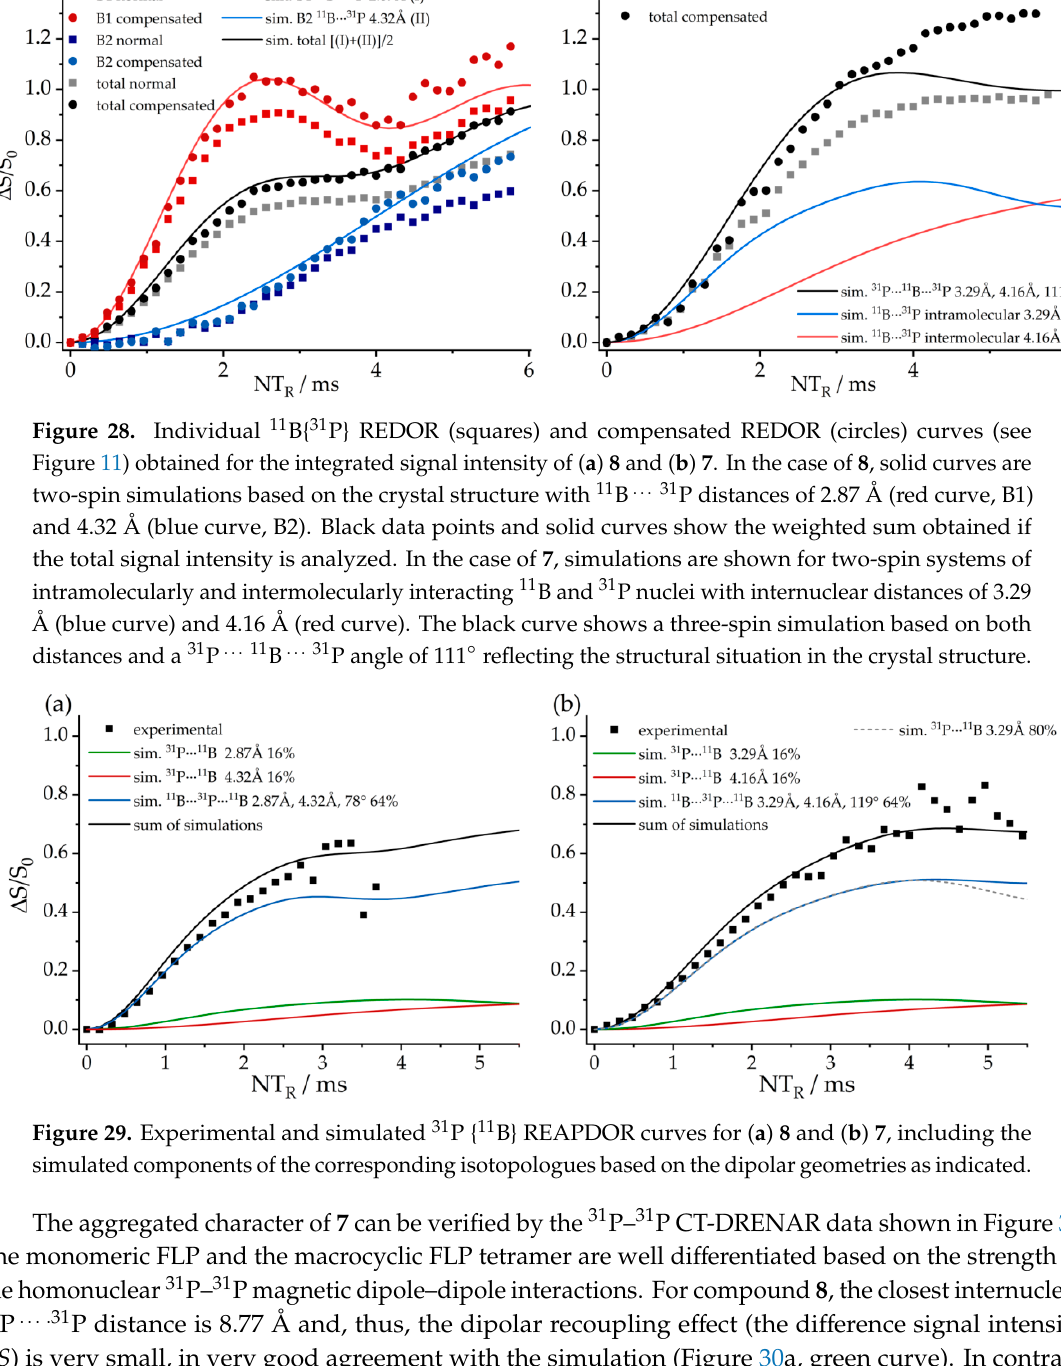
Figure 30. 31 P– 31 P CT-DRENAR curves (black squares) for ( a ) 8 and ( b ) 7 acquired for a dipolar recoupling time of 2.56 ms at 7.05 T, using a MAS frequency of 12.5 kHz with SWFTPPM [84] 1 H decoupling. The simulation in ( a ) is based on a two-spin system with a 31 P …31 P distance of 8.77 Å (green curve) based on the shortest internuclear distance in the single-crystal structure. In ( b ), two simulations are depicted: a hypothetical dimer (two-spin system, gray curve) and the tetramer (three- spin system, green curve). Each simulation considered a 31 P …31 P distance of 6.16 Å and, in the latter case, a 31 P …31 P …31 P angle of 76° based on the single-crystal structure. The agreement of the experimental data with the three-spin simulation gives clear evidence for the formation of the macrocycle. 3.6. An FLP-Cyclooctamer The six-membered cyclic B/P FLP 6 illustrated in Figure 31 shows a remarkable tendency for self-assembly at low temperatures in solution and upon crystallization, producing the cyclooctameric structure 9 with alternating chair- and boat-like conformations [86]. The boron and the phosphorus atoms are placed at the tip of the chair (B1 and P1), while, in the boat conformation, the FLP centers are part of the basis (B2 and P2) (see Figure 32). To facilitate the computation of the NMR observables, the simplified molecules 10a and 10b served as models of the corresponding cutouts of the molecular structure of 9 . The 11 B MAS and the 31 P{ 1 H} CP/MAS NMR spectra are shown in Figures 31c and 31d. The 11 B MAS NMR spectrum features two signals at isotropic chemical shifts of − 3.7 ppm and − 5.4 ppm. As already shown in Figure 6, the resolution can be significantly improved by the triple- quantum single-quantum correlation experiment; the INEPT method offers an alternative ( vide infra ). Each of the two resonances in the 31 P{ 1 H} CP/MAS NMR spectra centered at 20.0 ppm and 17.7 ppm in Figure 31d consists of two distinct isotopologue signals (due to the effect of 31 P– 11 B and 31 P– 10 B J-